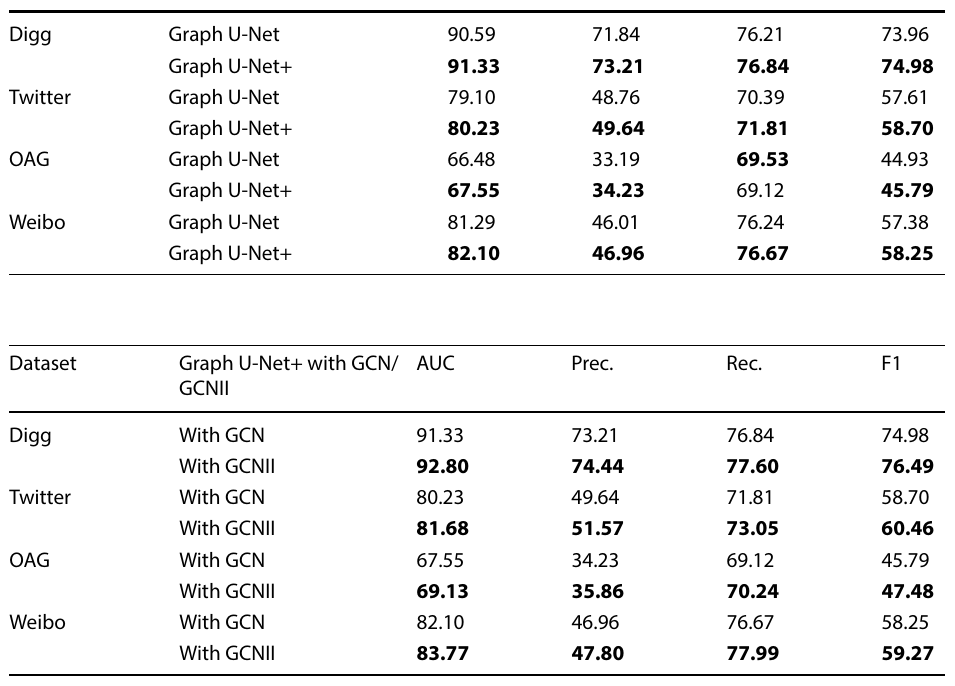
Table 4 Keep the original network layers of graph U-Net unchanged, and only change the network architecture from graph U-Net to graph U-Net+ ( % )